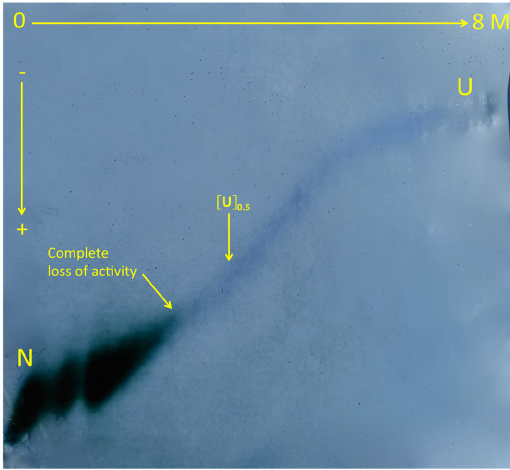
Figure 6. TUGGE of human butyrylcholinesterase tetramer. BChE (0.5 mg highly purified protein (>90% pure) in 0.5 mL electrophoresis buffer) was layered along the top of the 0–8 M TUGG. Migra- tion was performed at 0 °C under the constant intensity of 30 mA for 5.5 h in 50 mM Tris/Gly buffer pH 8.4. The unfolding transition curve was revealed by double staining: after electrophoresis,